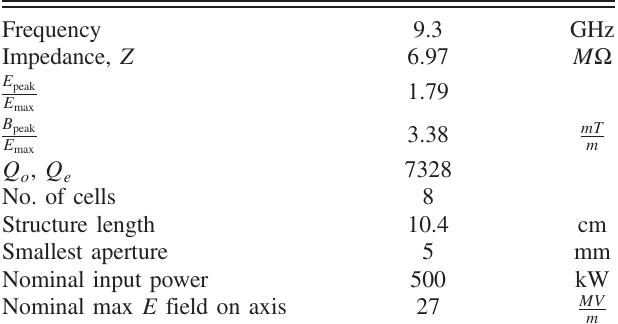
TABLE II. Cavity parameters.